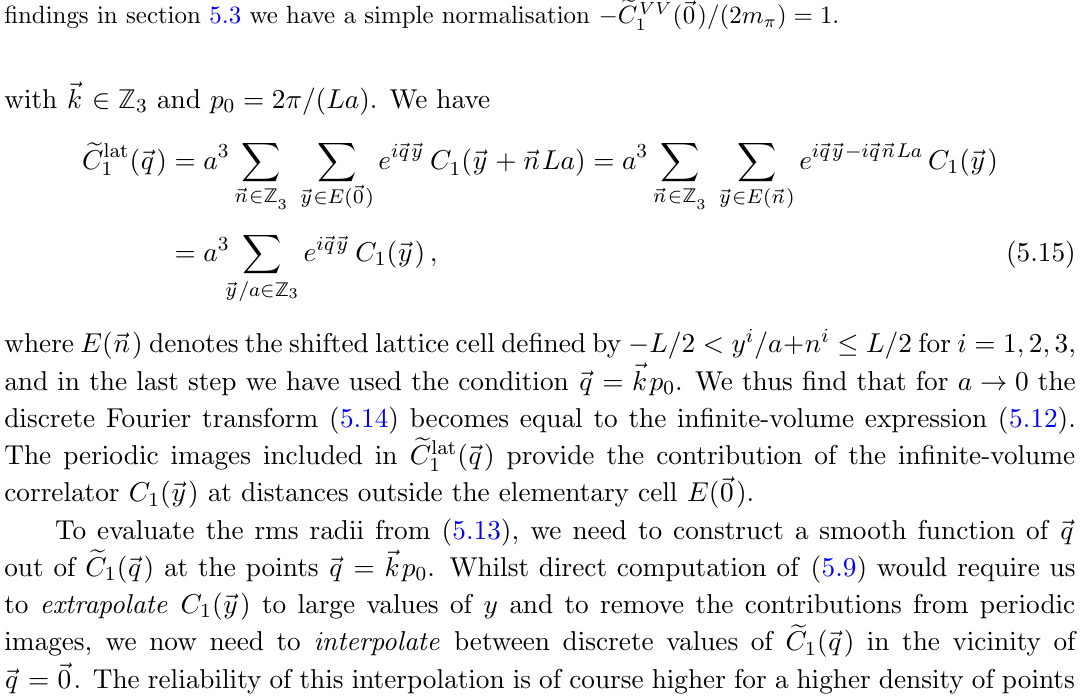
2 m (cid:25) , so that according to (cid:0)